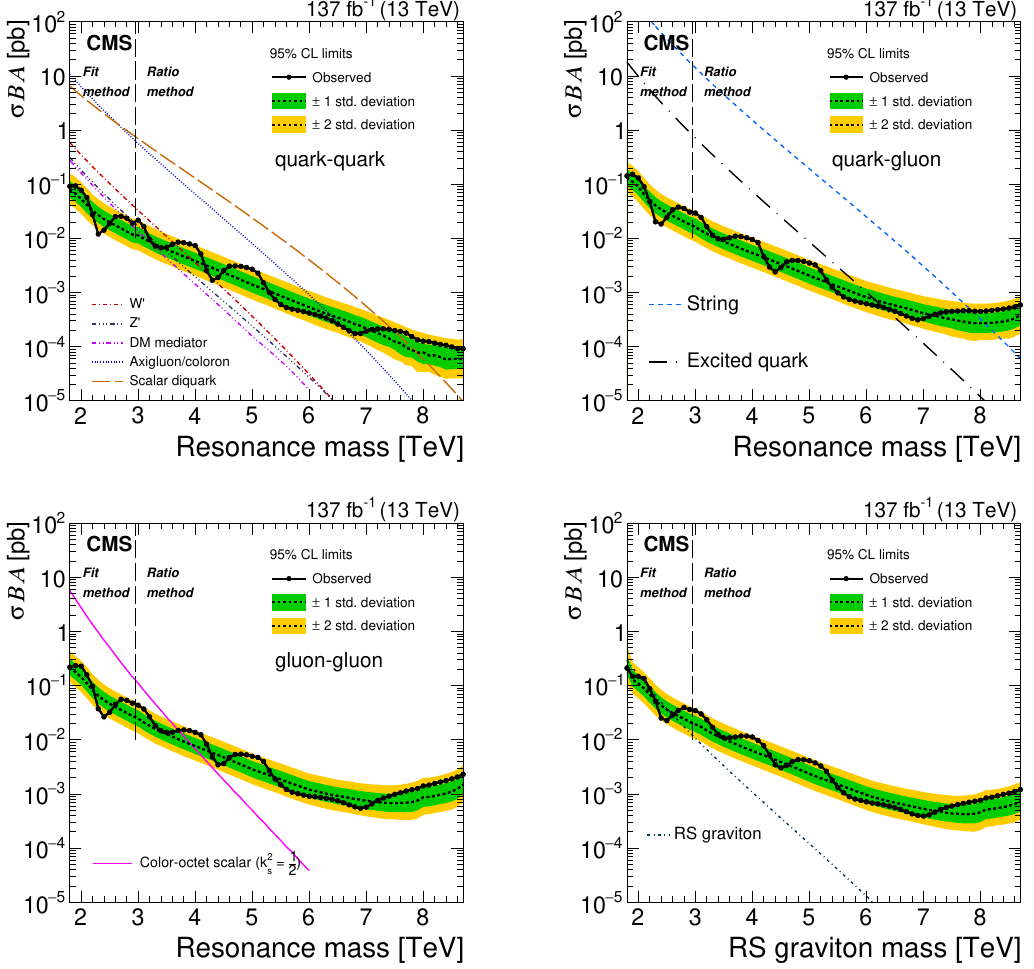
Figure 6 . The observed 95% CL upper limits on the product of the cross section, branching fraction, and acceptance for dijet resonances decaying to quark-quark (upper left), quark-gluon (upper right), gluon-gluon (lower left), and for RS gravitons (lower right). The corresponding expected limits (dashed lines) and their variations at the one and two standard deviation levels (shaded bands) are also shown. Limits are compared to predicted cross sections for string resonances [1, 2], excited quarks [4, 5], axigluons [6], colorons [8], scalar diquarks [3], color-octet scalars [9], new gauge bosons W 0 and Z 0 with SM-like couplings [10], DM mediators for m = 1 GeV [14, 15], and RS DM gravitons [11]. The vertical dashed line indicates the boundary between the regions where the (cid:12)t method and the ratio method are used to estimate the background.